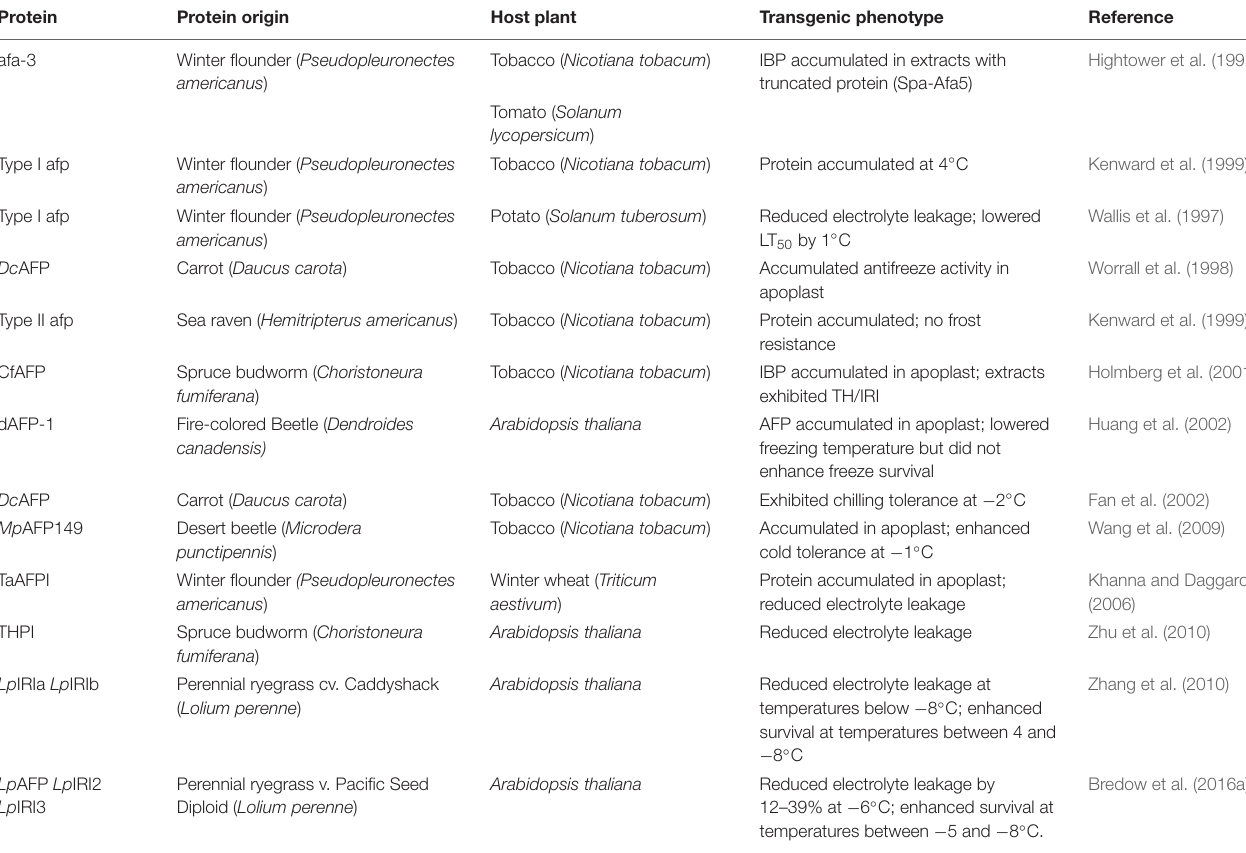
TABLE 2 | Transgenic plants expressing ice-binding proteins and antifreeze proteins (AFPs).